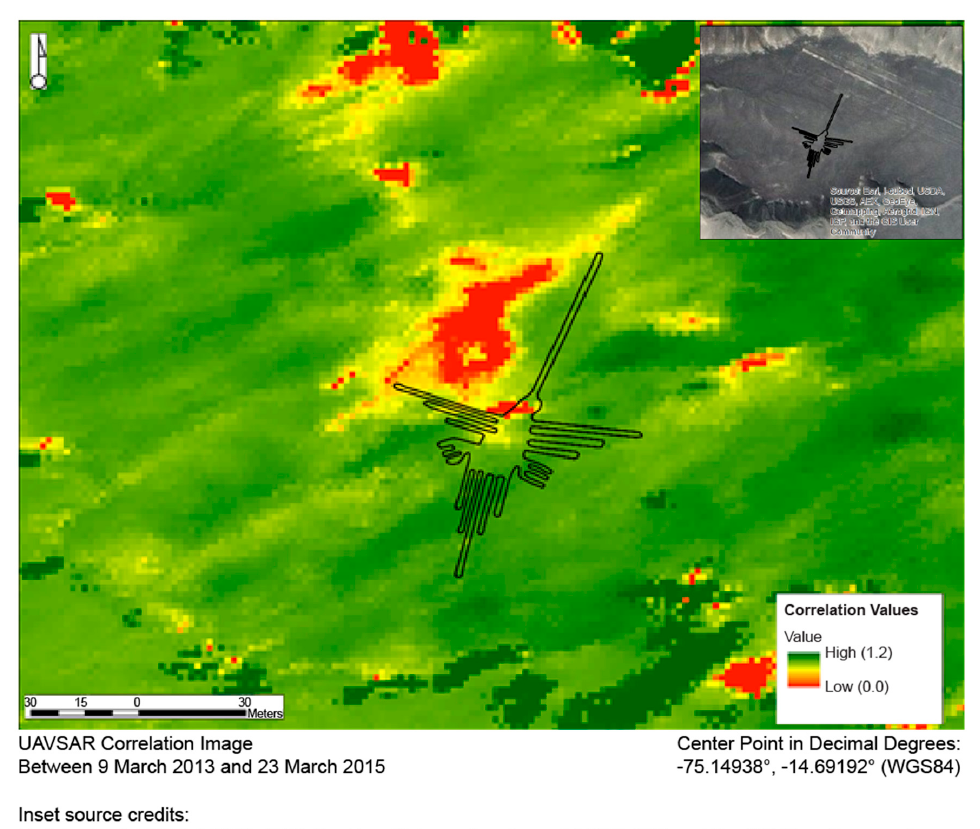
Figure 2. A correlation image of the Hummingbird glyph (outlined) after applying the colorized stretch (the inset shows an optical satellite image of the same area). Highly decorrelated areas are in red. These areas include those at which Greenpeace activists placed their message and prepared their materials, as well as the trail they took to reach the Hummingbird (extending southward from the top of the image). The other decorrelated areas correspond to steep slopes (visible in the inset) leading down from the pampas ; we found decorrelation in such areas to be common, because of gravity pulling sediment downslope.